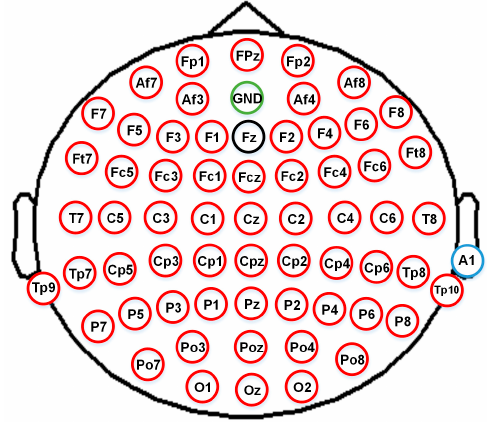
Figure 4. EEG cap layout for 62 channels.